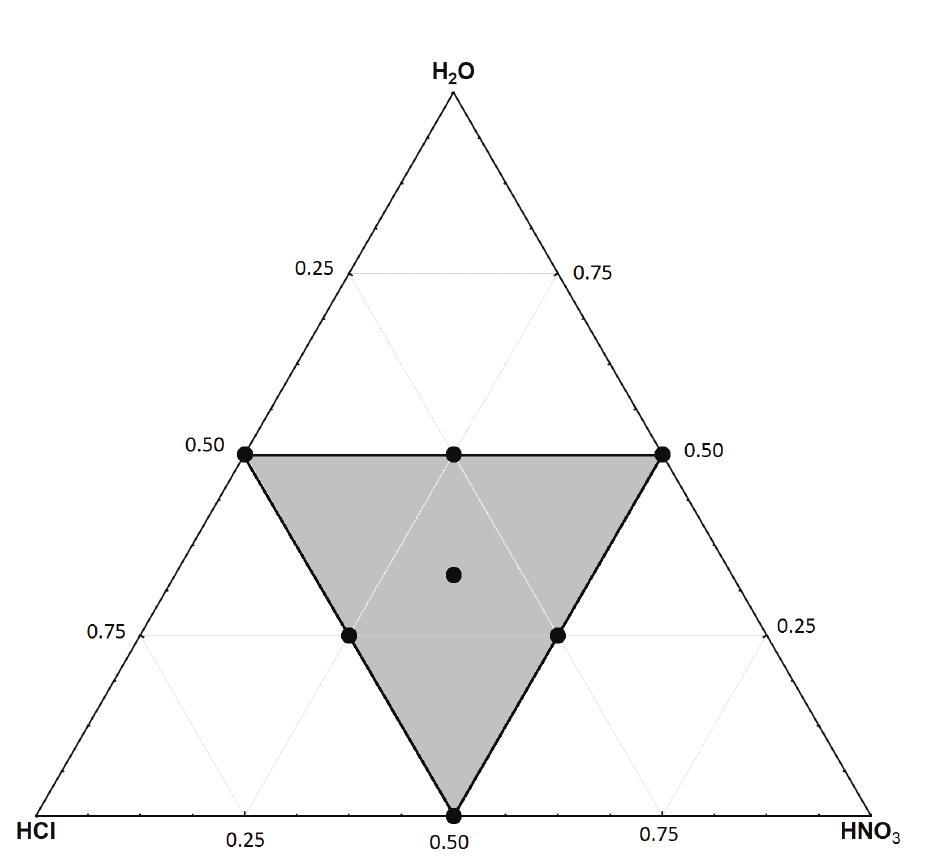
Figure 1 - Experimental region of the mixture design delimited by the high constraints established for each component according to Table